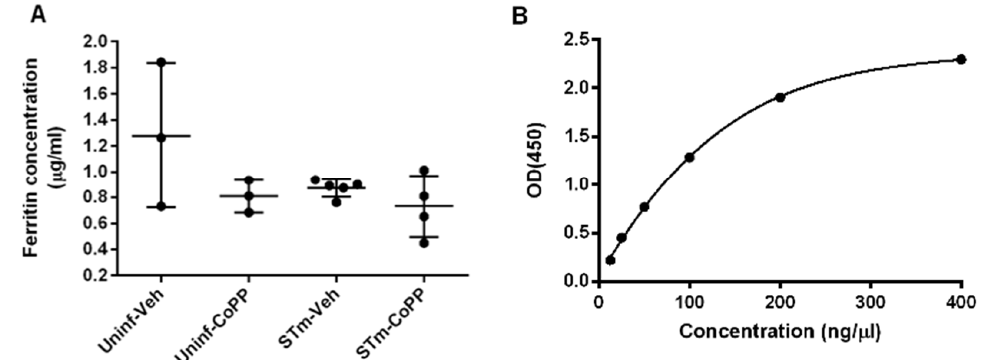
Figure A1. Ferritin levels evaluated by ELISA in sera of S. Typhimurium-infected mice untreated or CoPP-treated. ( A ). Female C57BL/6 mice were treated with CoPP or vehicle as uninfected controls. Twenty-four h later, mice were intragastrically infected with 1 × 10 6 CFU of S . Typhimurium 14028 and on day 6 post-treatment (day 5 post-infection of infected groups) serum was obtained to measure Ferritin using the Ferritin Mouse ELISA kit (Abcam). Serum samples were diluted at 1:40 and 1:200 and tested in duplicate. ( B ). Ferritin concentration in each sample was calculated based on the standard curve determined for each plate. No significant differences were observed.